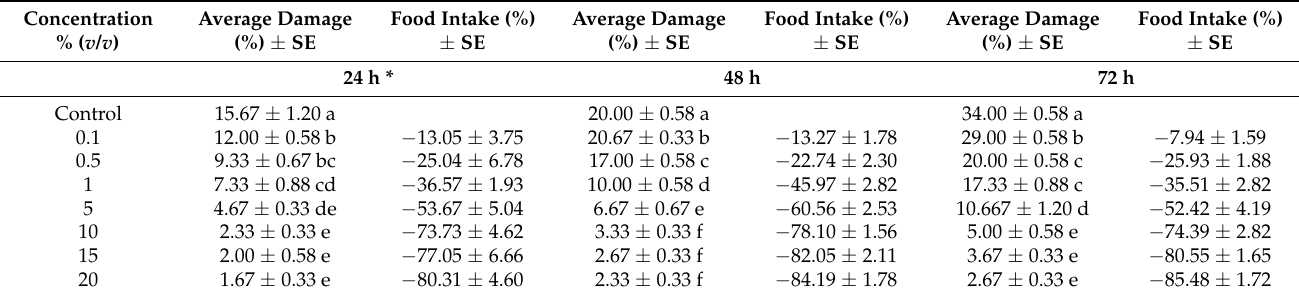
Table 6. Effects of Moringa oleifera leaf ethanolic extract of on Tetranychus merganser feeding rate. Concentration Average Damage % ( v / v ) (%) ±